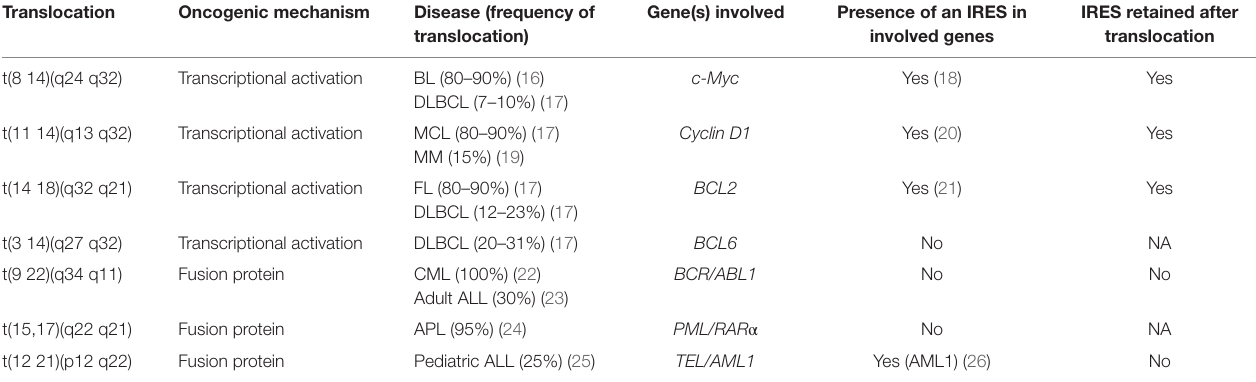
TABLe 1 | Genes with the most common translocations observed in blood cancer. Translocation Oncogenic mechanism Disease (frequency of